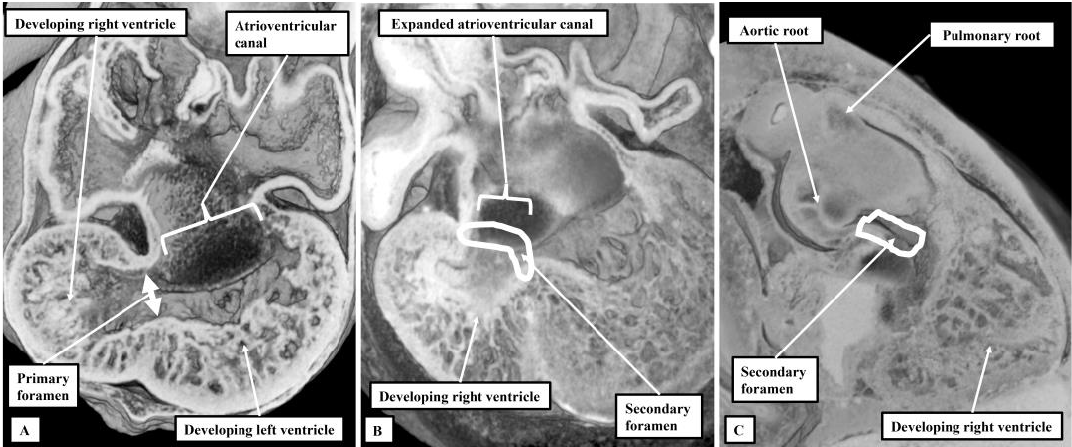
Figure 1. The images show the initial stages of formation of the ventricles in the human heart. Panel ( A ) shows a “four chamber” section at Carnegie stage 14, during the fifth week of development. The atrioventricular canal is supported exclusively by the developing left ventricle. Later in the fifth week, at Carnegie stage 15, as shown in panel ( B ), another four chamber section, the atrioventricular canal expanded to bring the cavity of the right atrium into communication with the developing right ventricle. This resulted in remodeling of the primary interventricular communication. As is shown in panel ( C ), also at Carnegie stage 15, but now showing the septal surface of the right ventricle, the secondary interventricular communication now provides the outlet for the developing left ventricle.